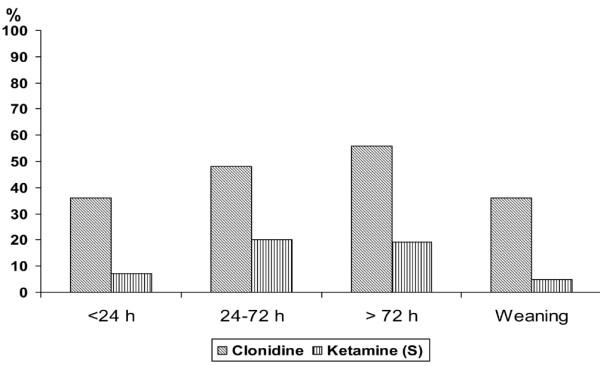
The most commonly used adjunct techniques in the different phases of analgesia and sedation. The values were tested with the χ2 test (P < 0.05) and multiple differences with the Bonferroni–Holm multiple test procedure. (Clonidine: less than 24 hours versus more than 72 hours, less than 24 hours versus weaning and 24–72 hours versus weaning, all P < 0.01; 24 hours versus 24–72 hours, P = 0.23; 24–72 hours versus more than 72 hours, P < 0.017; more than 72 hours versus weaning, P = 0.067. Ketamine (S): less than 24 hours versus 24–72 hours, less than 24 hours versus more than 72 hours, 24–72 hours versus weaning and more than 72 hours versus weaning, all P < 0.0001; less than 24 hours versus weaning, P = 0.22; 24–72 hours versus more than 72 hours, P = 0.087.)